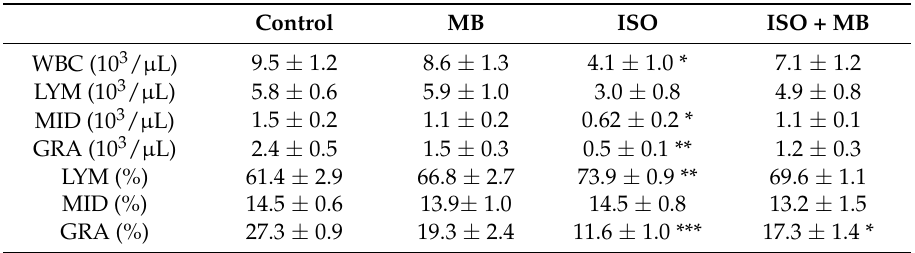
Table 2. Effect of M. bijugatus on white cell parameters in ISO-induced cardiac injury.